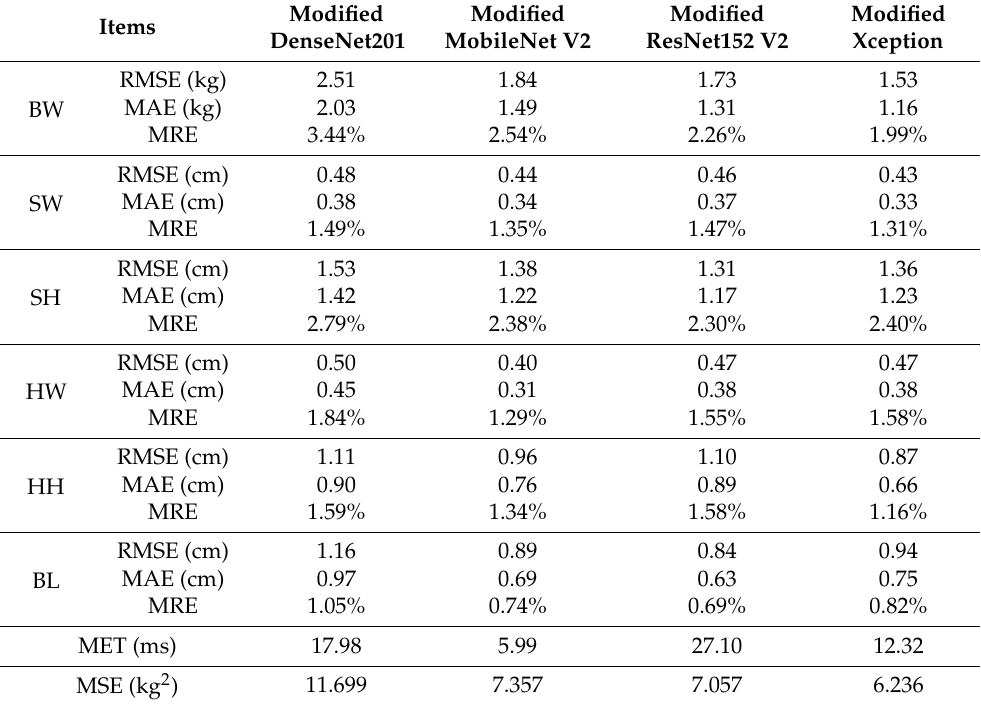
Table 3. Performance of the models on the test set. BW: body weight; SW: shoulder width; SH: shoulder height; HW: hip width; HH: hip height; BL: body length; RMSE: root mean square